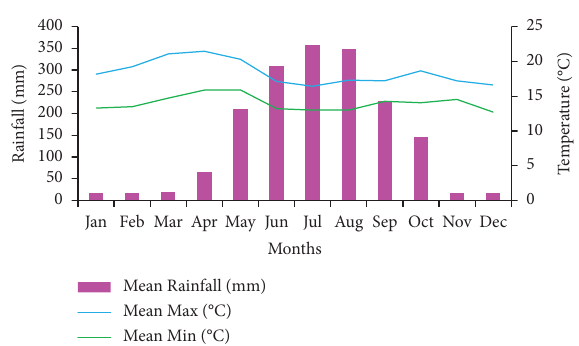
Figure 1: Mean monthly rainfall and temperature recorded for last fve years